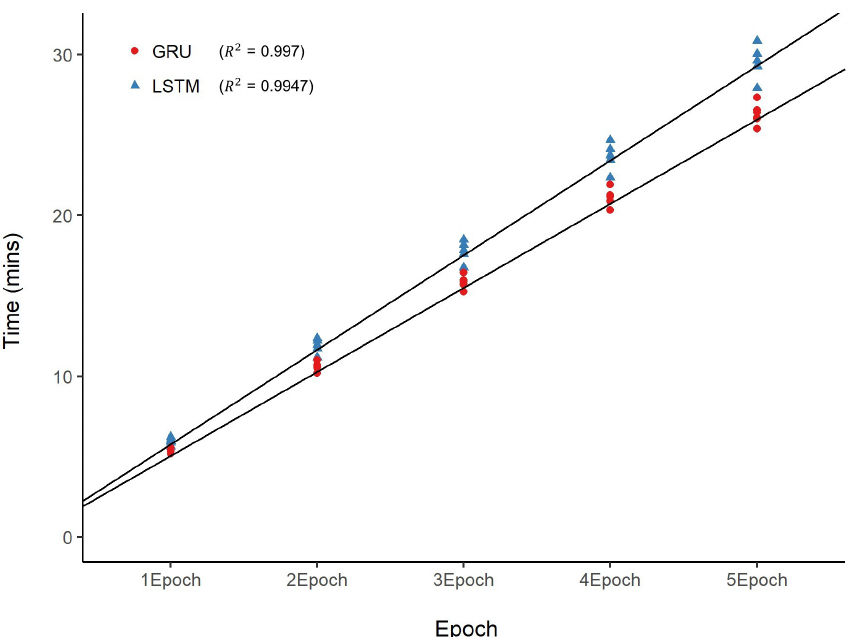
Figure 11. Scalability comparisons between gated recurrent unit (GRU) and long short-term neural network (LSTM)